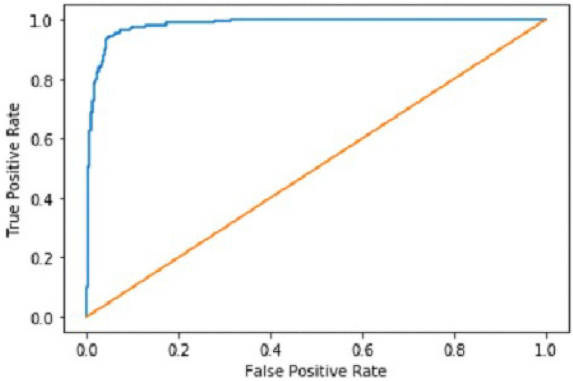
Figure 20. ROC curve of deep ensemble 2D CNN.